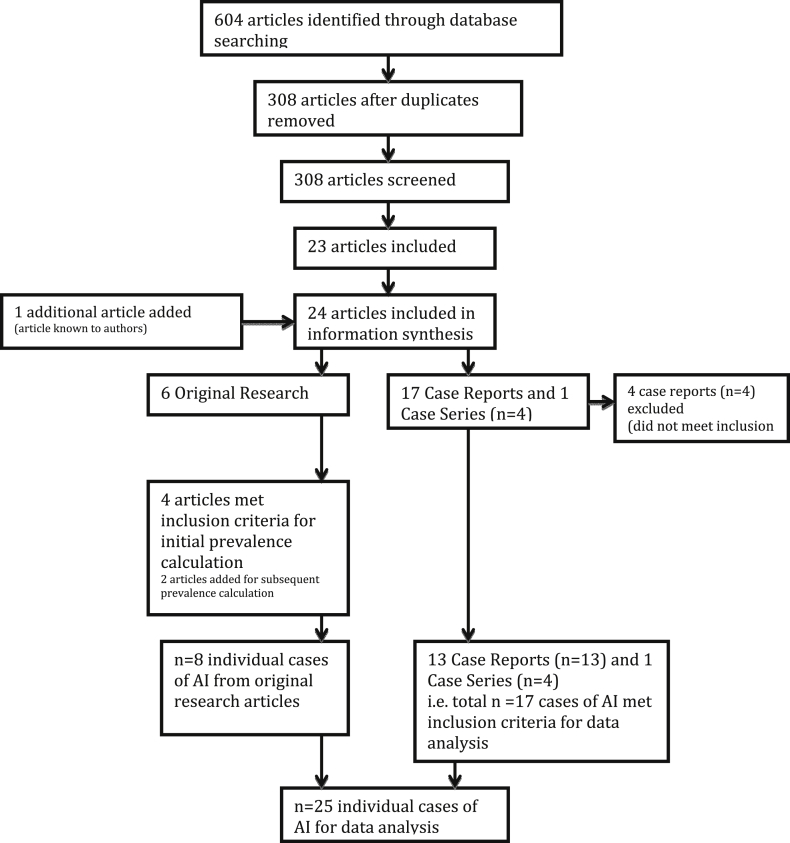
Flow diagram of process of systematic review.